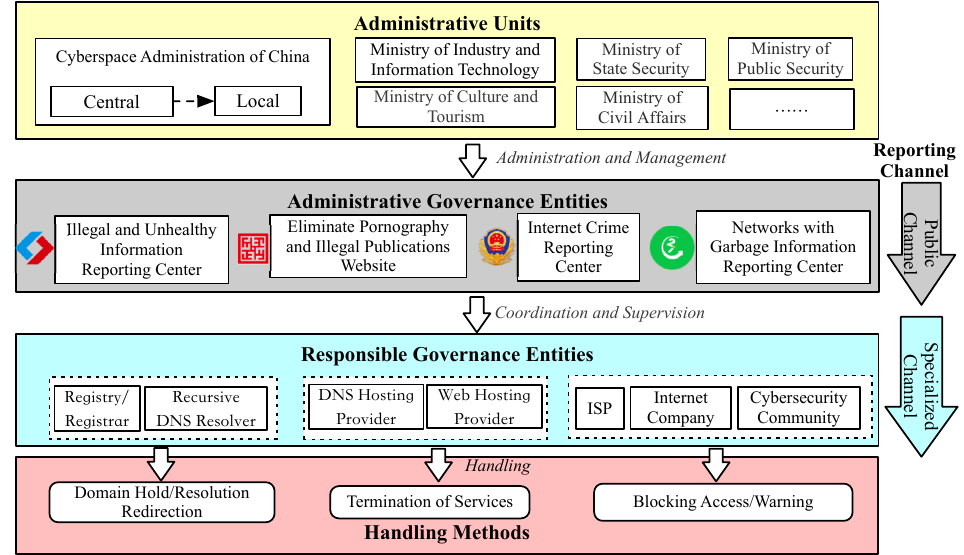
Figure 2. Handling Abusive domain name framework and reporting